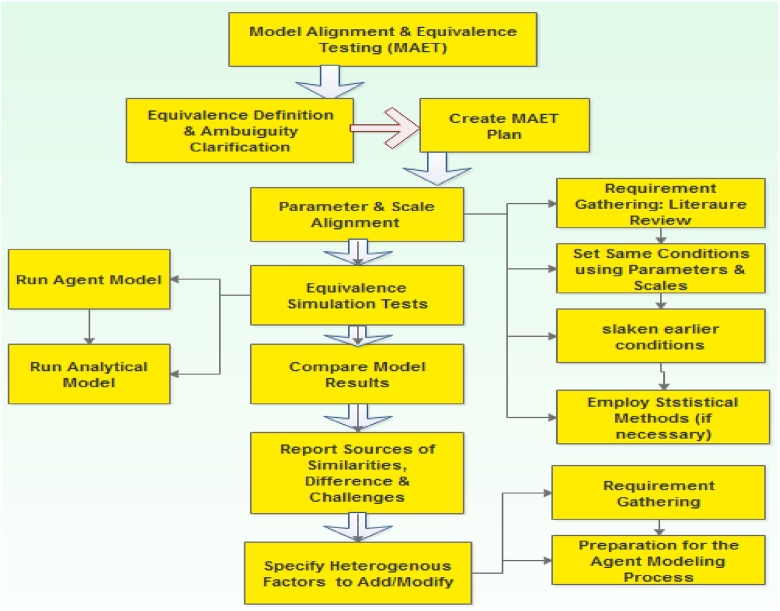
MAET process for A2CDSADM.